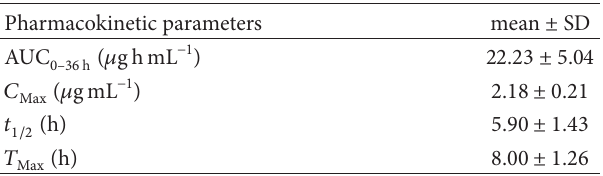
Table4:Pharmacokineticparametersobtainedafteradministration of ergosterol in SD rats ( 𝑛 = 6